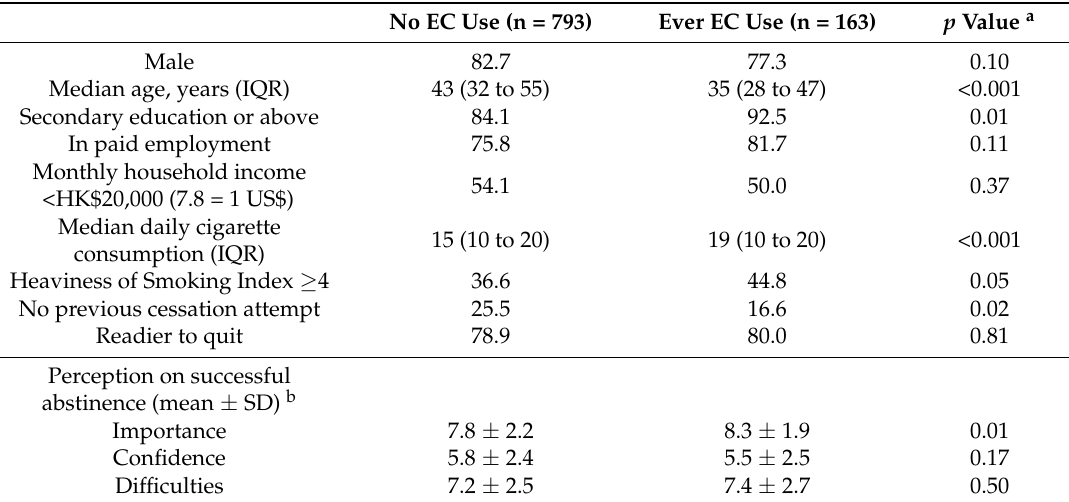
Table 2. Participants’ baseline